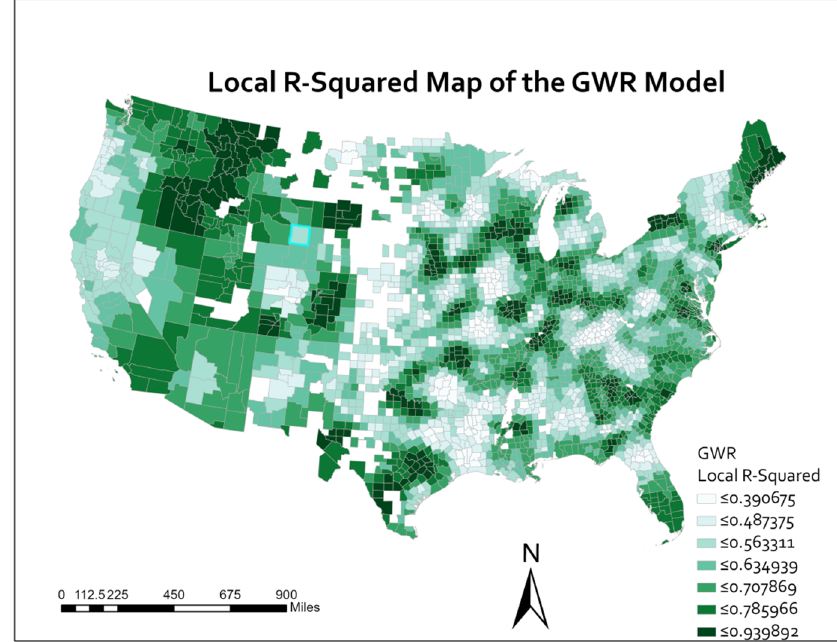
Figure 13. Local R 2 map of the GWR model.